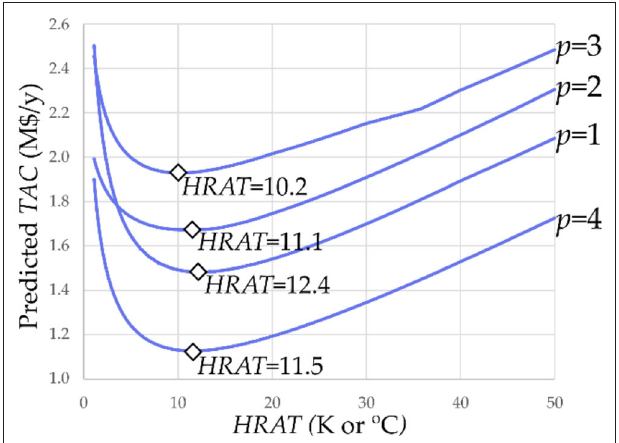
FIGURE 2 | Identification of optimal HRAT for each period conditions.